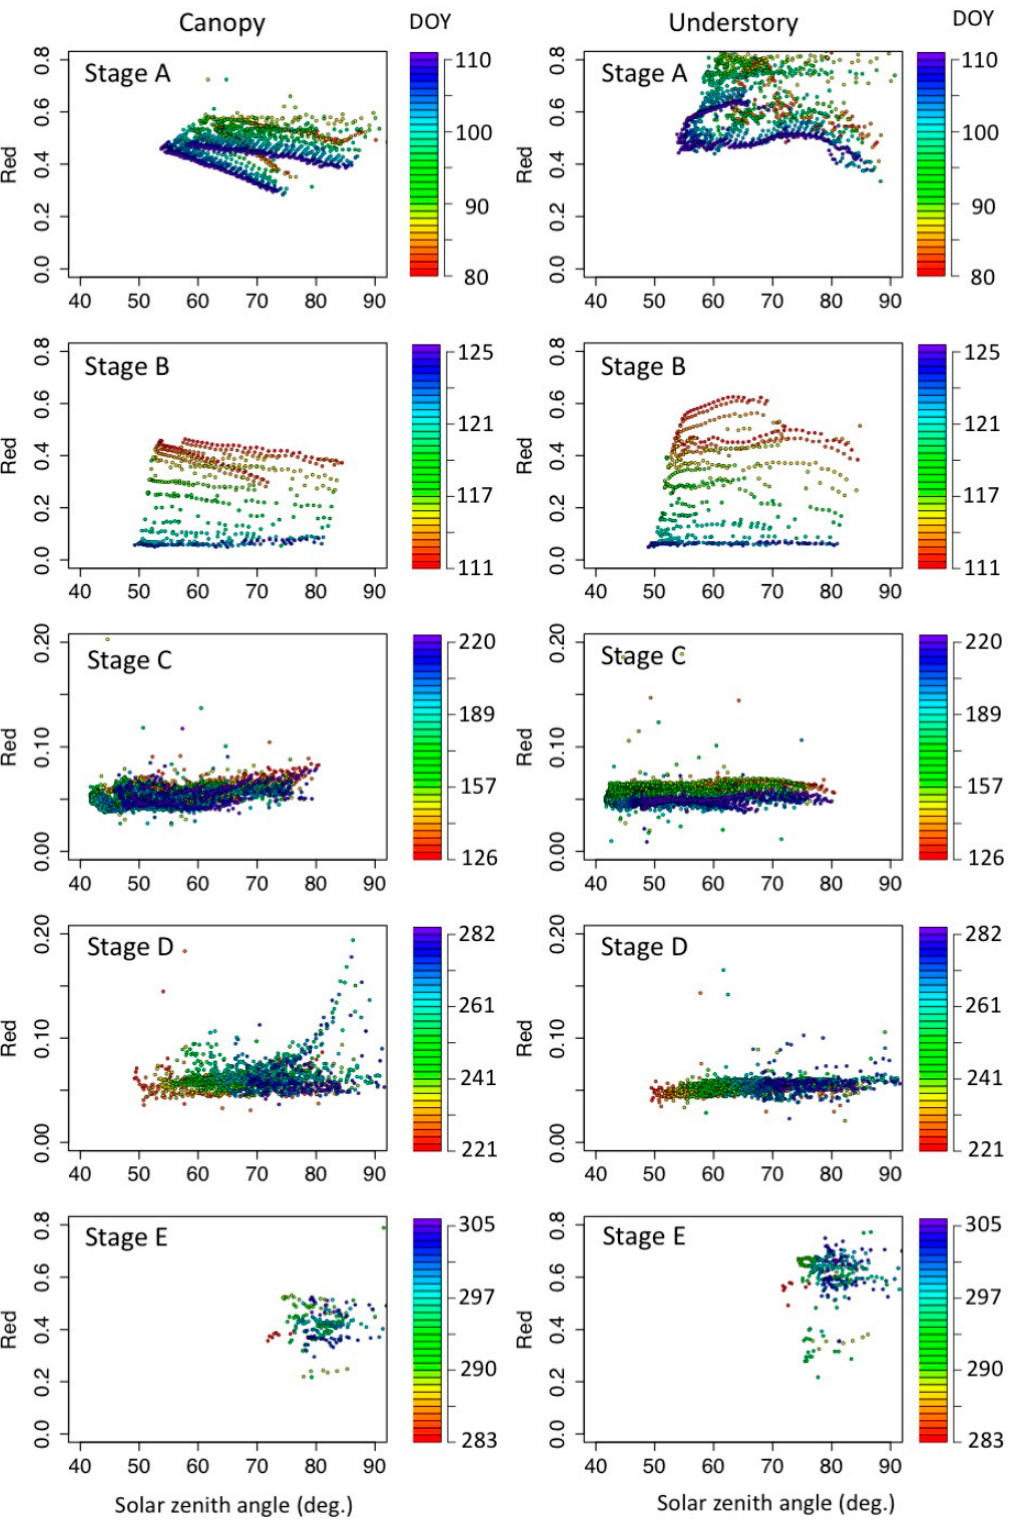
Figure A2. Solar zenith angle dependency of Red in five phenological stages. The definition of phenological stages are shown in Figure 2. Left : canopy Red (measured at the top of the tower). Right : understory measurements. Colors on the plotted circles denote the DOY of the measurements.